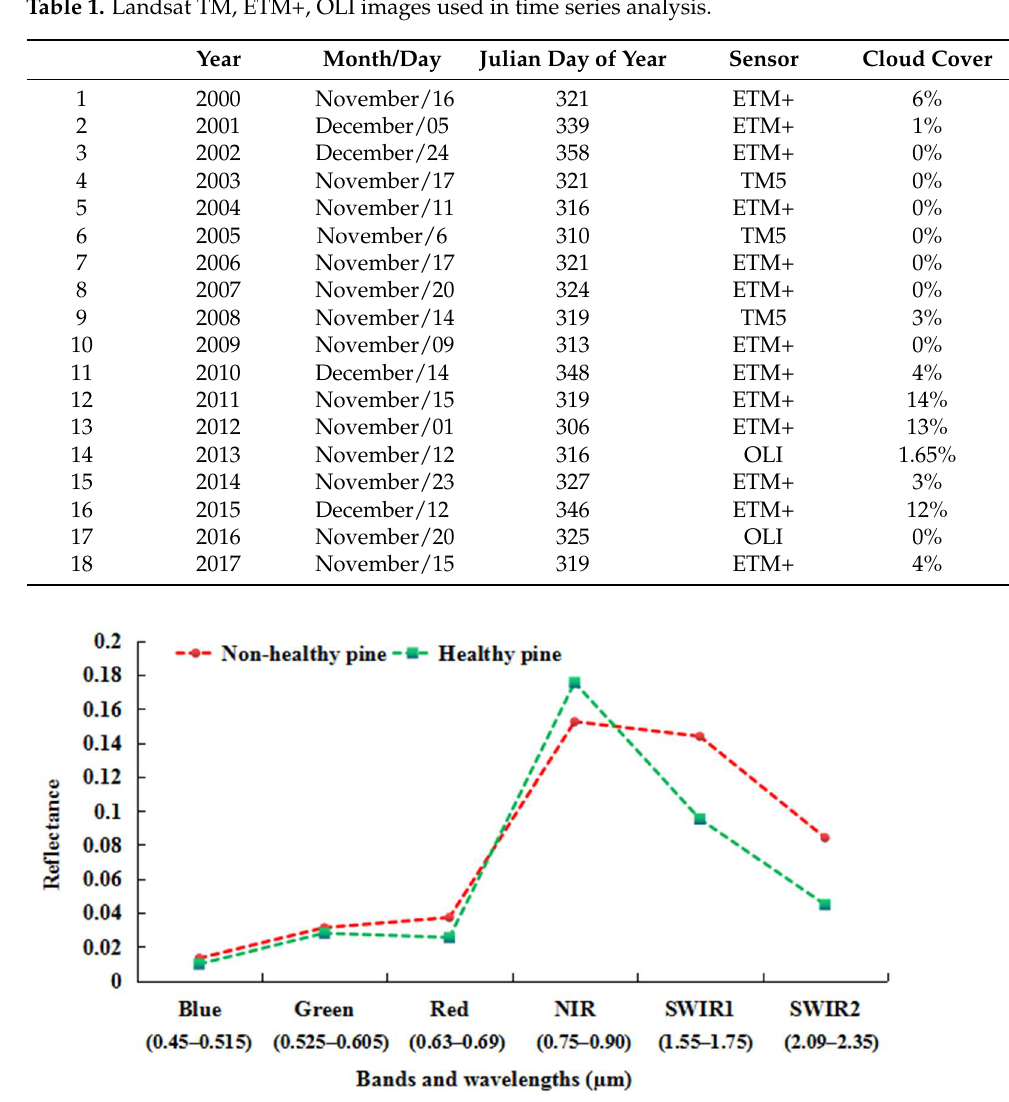
Table 1. Landsat TM, ETM+, OLI images used in time series analysis.